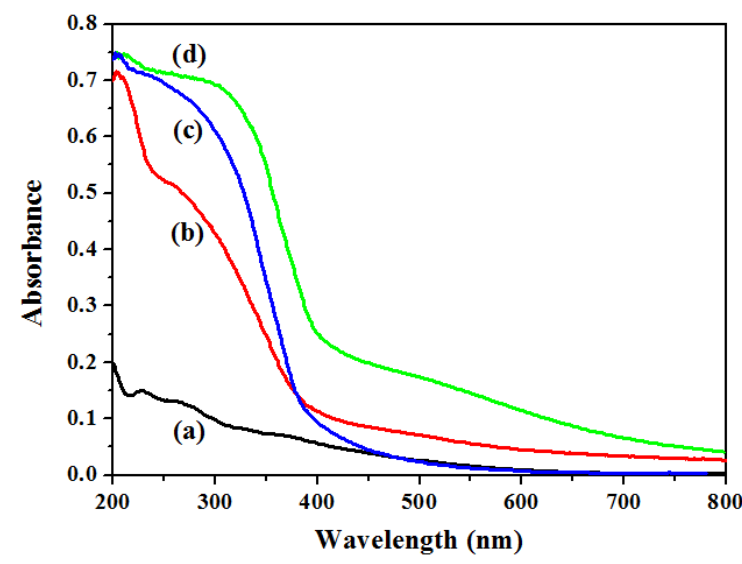
Figure 5. UV–vis absorption spectra of neat paper ( a ), paper–TiO 2 ( b ), fresh paper–TiO 2 –AgBr ( c ) and paper–TiO 2 –AgBr after photocatalytic test ( d ).